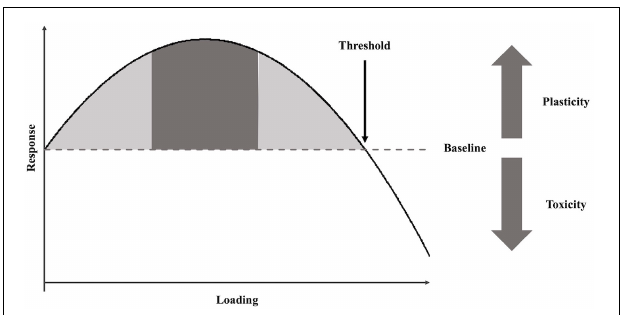
FIGURE 1 | Hypothetical hormetic (i.e. biphasic) response curve for athletic performance training. The solid black line represents the system’s response to the increasing stress load relative to the system’s baseline (dashed line). The gray areas represent a system’s plasticity (or antifragility), while the dark gray area represents the maximum response of a